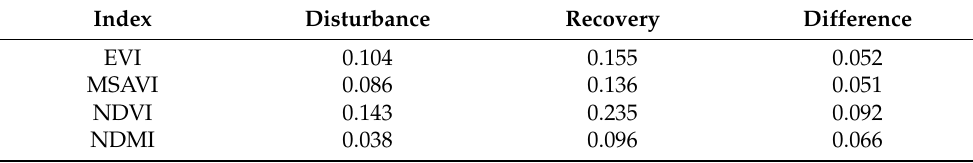
Figure 9. Spatial pattern of post disturbance recovery (show in green). Table 2. Averaged median values of disturbed and recovery period and their difference.